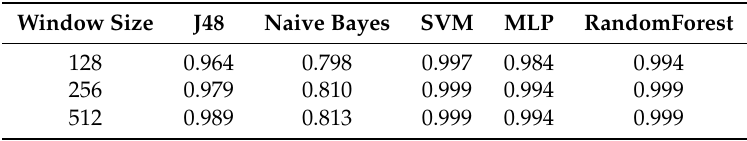
Table 7. Basic performance in the relationship between classification accuracy vs . window size and the classifier (10-fold